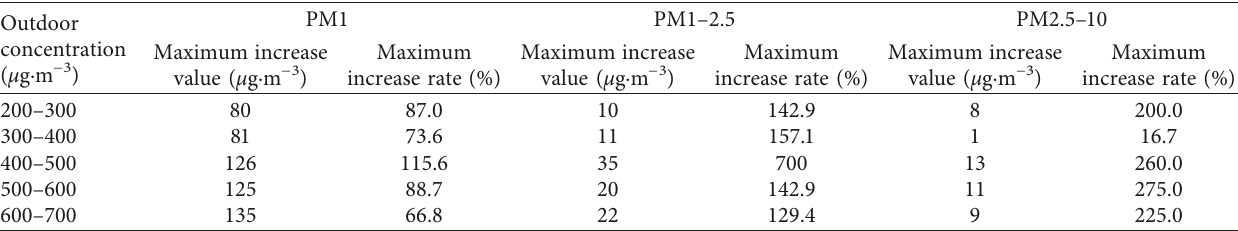
Table 2: The variation of particles in different sizes under different